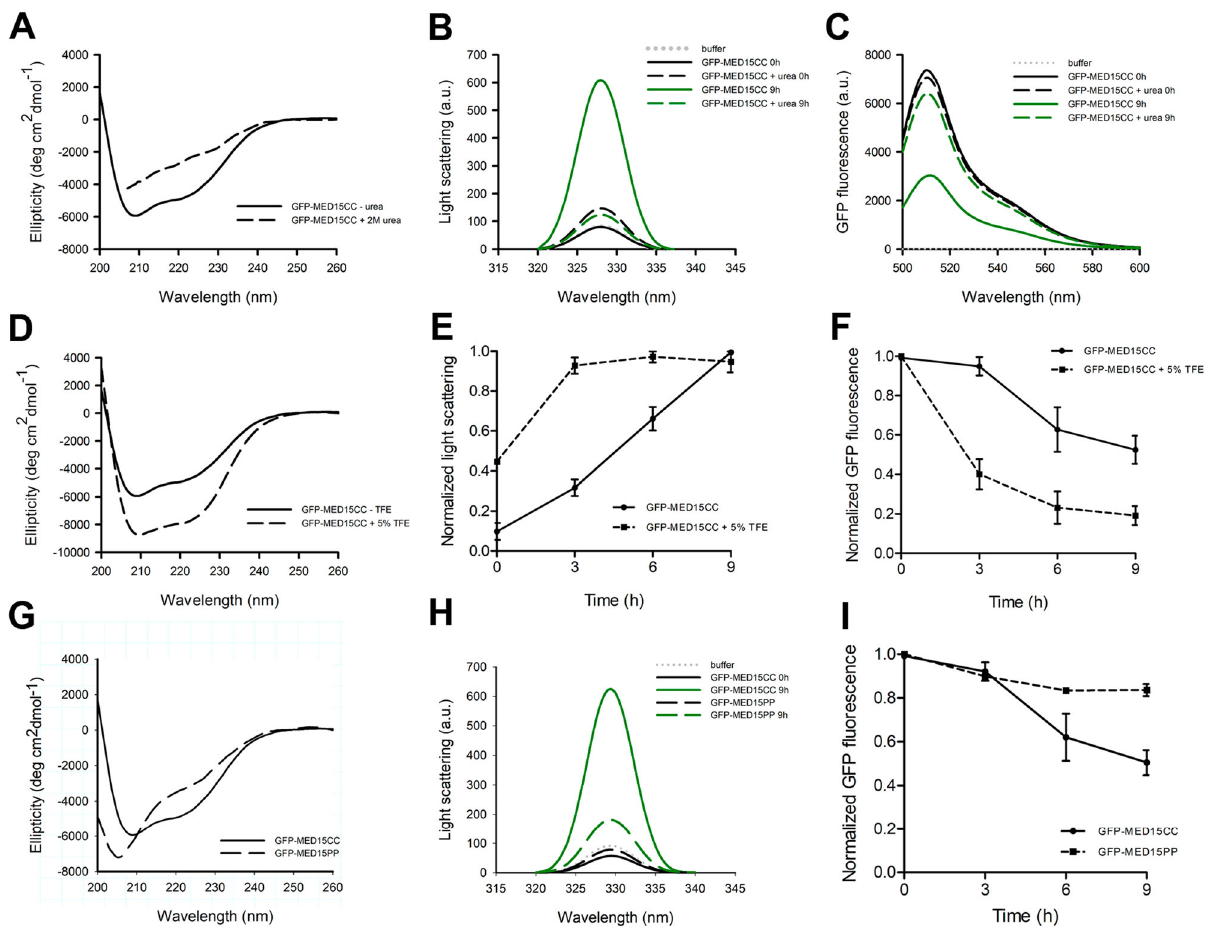
Fig. 5 MED15-PrLD aggregation is governed by its coiled-coil conformation. A Circular dichroism, B light scattering, and C GFP fl uorescence (supernatant fraction) of 5 μ M GFP-MED15CC in the absence or presence of 2 M urea. D Circular dichroism, E light scattering kinetics, and F GFP fl uorescence kinetics (supernatant fraction) of 5 μ M GFP-MED15CC in the absence or presence of 5% TFE. G Circular dichroism, H light scattering, and I GFP fl uorescence kinetics (supernatant fraction) of 5 μ M GFP-MED15CC or GFP-MED15PP. In all cases, aggregation was performed for 9 hours at 37 °C without agitation in 20 mM Tris pH 7.5 and 150 mM